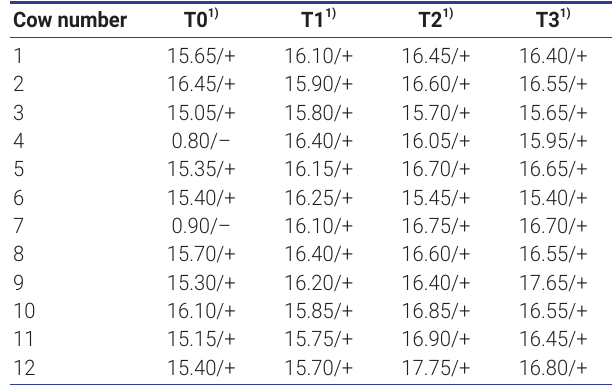
Table 3. Progesterone serum level (ng/mL) of cows recipients at day 21 and the results of pregnancy diagnosis through transrectal palpation at day 90 post-AI, using frozen semen in SM-EY extender with the addition of GTE at various doses